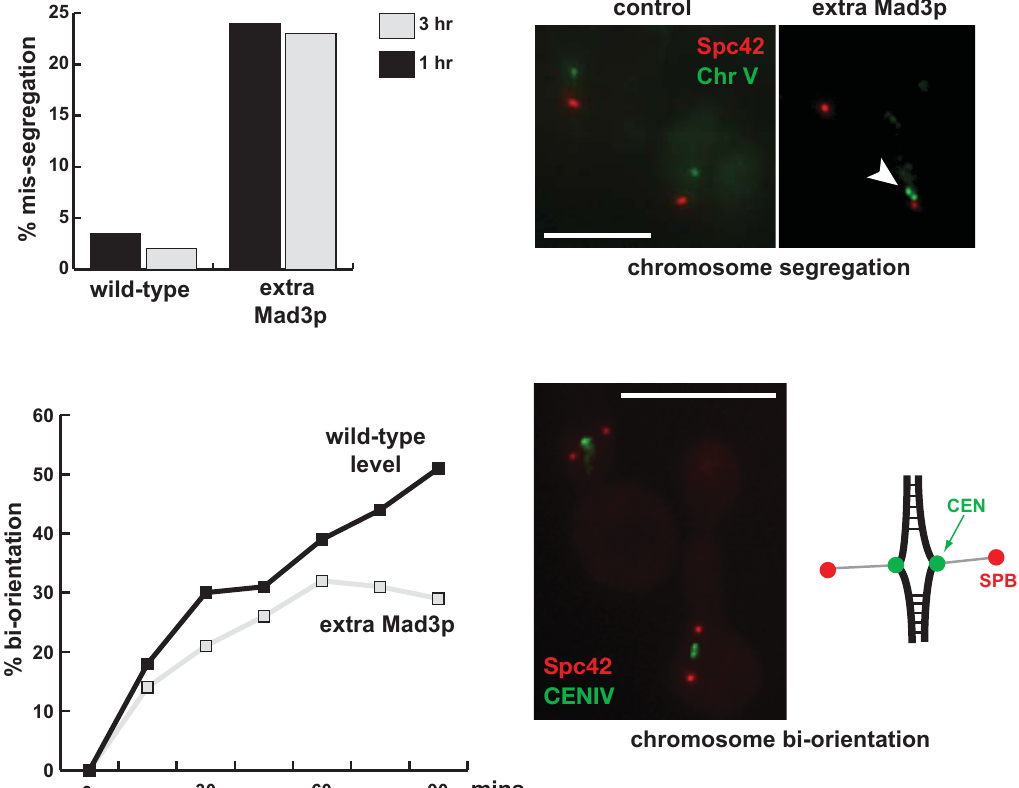
Figure 7. Over-expression of Mad3p induces bi-orientation and chromosome segregation defects. A) Mad3p overexpression induces chromosome mis-segregation following checkpoint ‘‘challenge’’. Strains were pre-synchronised with a -factor, released and then arrested with nocodazole. The nocodazole was then washed out and cells arrested in the next G1. Cells were fixed and analysed for the presence of GFP-marked chromosomes. Chromosome V was labelled with GFP and spindle poles with SPC42-mCherry. Arrowheads mark G1 cells containing two copies of chromosome V. B) Mad3p overexpression induces chromosome bi-orientation defects. Cells were pre-synchronised with a -factor, then depleted for Cdc20p through the addition of Methionine. Cells were then released from G1 into media containing nocodazole and benomyl. The microtubule drugs were then washed out to allow soindle assembly, but Cdc20p remained represed to arrest cells in metaphase. Cells were briefly fixed and scored for bi-orientation (breathing centromeres). Centromere IV was labelled with GFP and spindle poles with SPC42 -tomato. Scale bars are 5